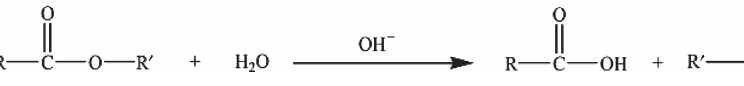
Figure 8: Alkali hydrolysis progress of ester